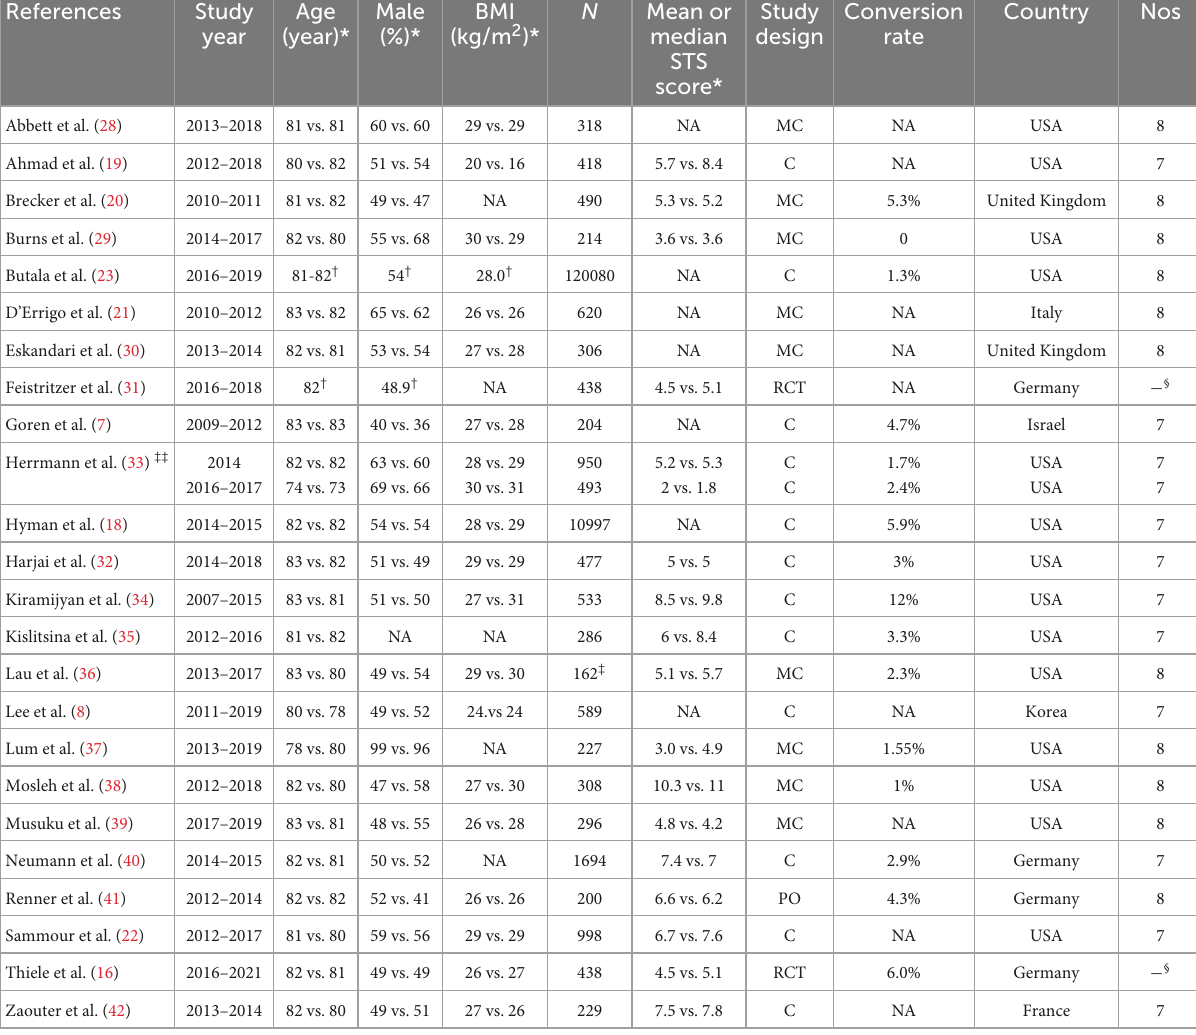
TABLE 1 Studies characteristics of included studies ( n =